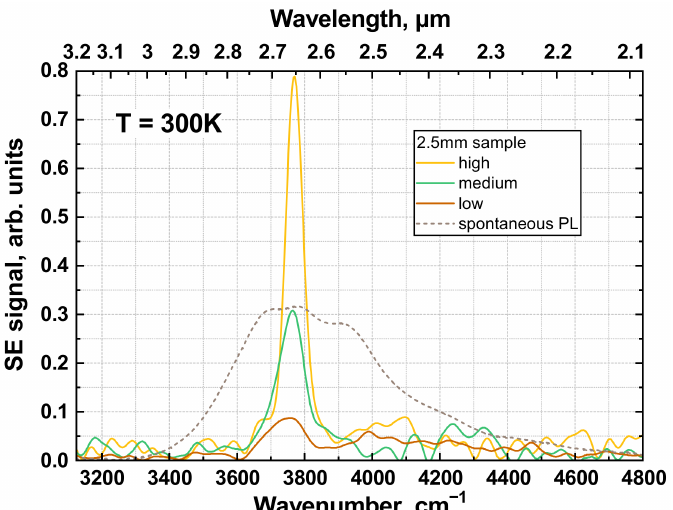
Figure 2. Stimulated emission (SE) spectra (solid lines) at 2.65 µ m under various excitation intensities of 1.6 µ m pulsed excitation (source (i)) and spontaneous emission spectrum under 808 nm continuous- wave diode excitation in the 2.5 mm sample. The low excitation intensity corresponded to less than 2 × 10 24 s − 1 cm − 2 photon flux, the medium one corresponded to ~(3 ÷ 3.5) × 10 24 s − 1 cm − 2 photon flux, and the high one to at least 4.5 × 10 24 s − 1 cm − 2 photon flux. For more detailed studies, we switched to 2 µ m OPO for the excitation of SE.